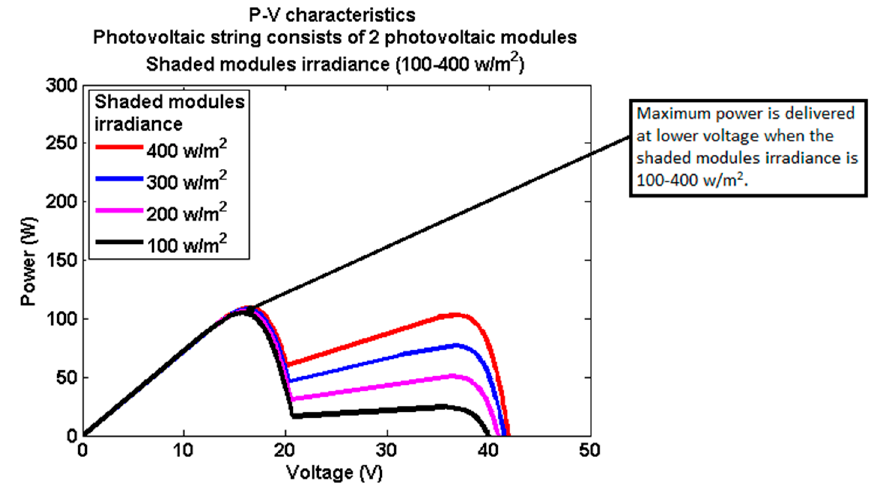
Figure 24. Simulated P-V characteristics of photovoltaic string in Figure 22—shaded module irradiance is between 0 and 400 w/m 2 .